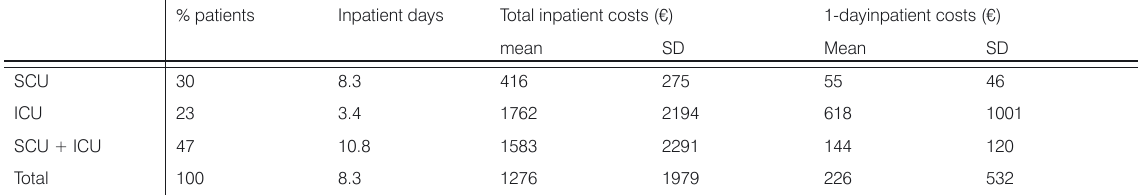
Table 2. Comparison between costs of standard cardiology unit (SCU) and intensive care unit (ICU); mean values with standard deviation (SD).